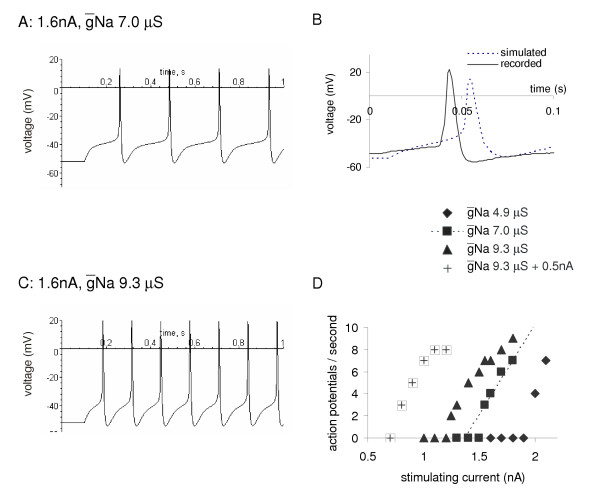
Simulation of constant current injection into the B1 motoneuron in normal saline and with octopamine. A. A current pulse of 1.6 nA with g¯
 MathType@MTEF@5@5@+=feaafiart1ev1aaatCvAUfKttLearuWrP9MDH5MBPbIqV92AaeXatLxBI9gBaebbnrfifHhDYfgasaacH8akY=wiFfYdH8Gipec8Eeeu0xXdbba9frFj0=OqFfea0dXdd9vqai=hGuQ8kuc9pgc9s8qqaq=dirpe0xb9q8qiLsFr0=vr0=vr0dc8meaabaqaciGacaGaaeqabaqabeGadaaakeaacuqGNbWzgaqeaaaa@2E1B@Na at 7 μS, the normal values, depolarises the B1 motoneuron from its resting value of -52 mV and generates four action potentials during the 1 s of simulation. B. Comparison of the action potential generated by simulation with one recorded in a constant current experiment in normal saline (initial resting potential -48 mV, slightly depolarised compared to the mean B1 resting potential, -55 mV). C. The same current pulse as A, but with g¯
 MathType@MTEF@5@5@+=feaafiart1ev1aaatCvAUfKttLearuWrP9MDH5MBPbIqV92AaeXatLxBI9gBaebbnrfifHhDYfgasaacH8akY=wiFfYdH8Gipec8Eeeu0xXdbba9frFj0=OqFfea0dXdd9vqai=hGuQ8kuc9pgc9s8qqaq=dirpe0xb9q8qiLsFr0=vr0=vr0dc8meaabaqaciGacaGaaeqabaqabeGadaaakeaacuqGNbWzgaqeaaaa@2E1B@Na increased by 33% to simulate the effect of 10 μM octopamine and generates 7 action potentials. D. A plot of the firing rate of the simulated B1 motoneuron with different parameters reflecting octopamine action. The squares and dotted line represent the firing rate of the normal model. The triangles show the effect of increasing the maximum sodium conductance (g¯
 MathType@MTEF@5@5@+=feaafiart1ev1aaatCvAUfKttLearuWrP9MDH5MBPbIqV92AaeXatLxBI9gBaebbnrfifHhDYfgasaacH8akY=wiFfYdH8Gipec8Eeeu0xXdbba9frFj0=OqFfea0dXdd9vqai=hGuQ8kuc9pgc9s8qqaq=dirpe0xb9q8qiLsFr0=vr0=vr0dc8meaabaqaciGacaGaaeqabaqabeGadaaakeaacuqGNbWzgaqeaaaa@2E1B@Na) by 33% simulating 10 μM octopamine, reducing the threshold and increasing the firing rate. The crosses show the effect of modelling the increased maximum sodium conductance plus a 0.5 nA octopamine current to simulate the depolarising effect of a higher concentration of octopamine, 100–200 μM, [39]. A further increase in excitability is seen. Decreasing the maximum sodium conductance reduces the number of action potentials (diamonds). Compare these figures with the data shown in Fig. 1A.